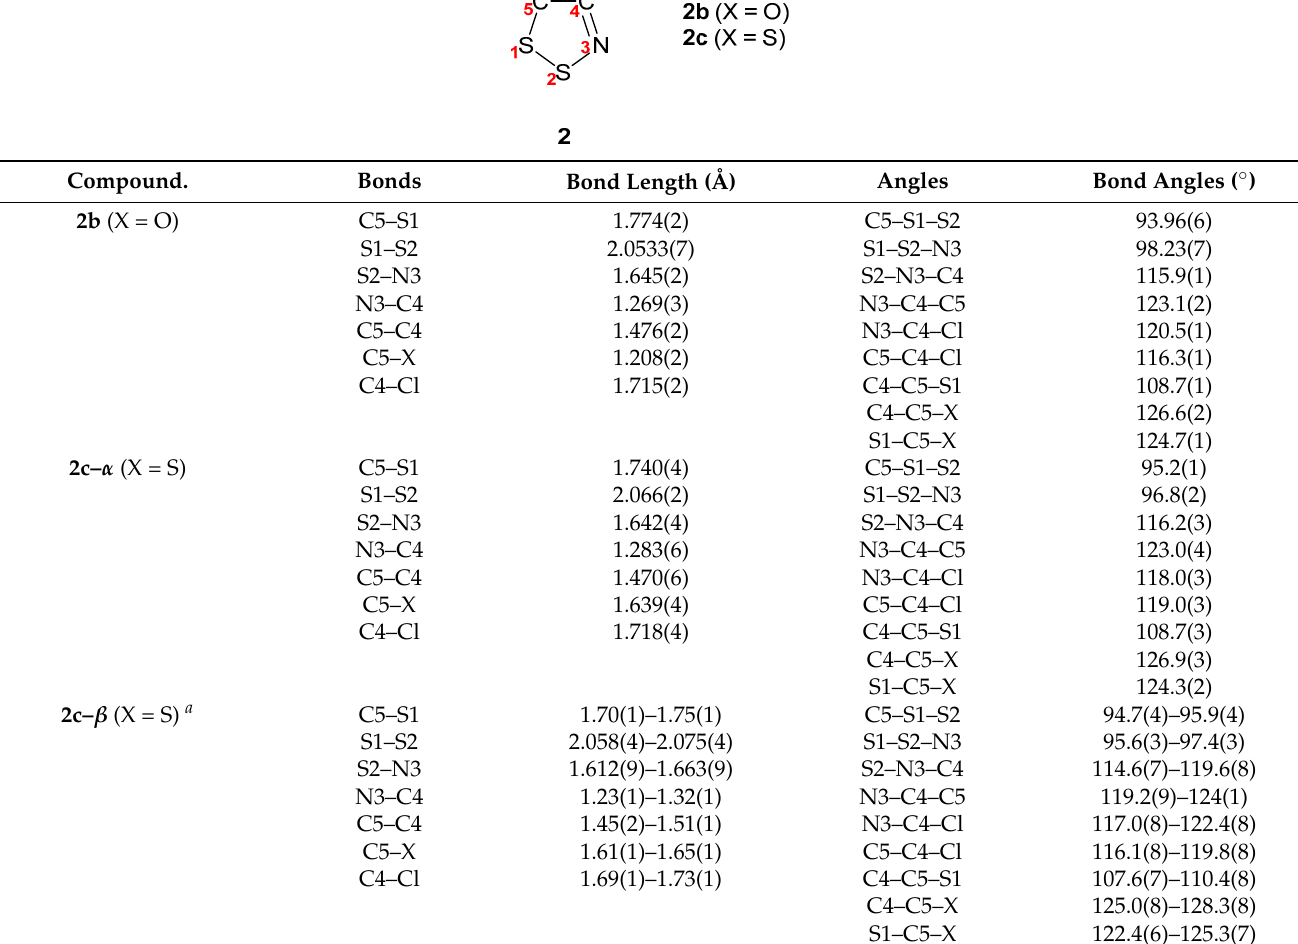
Molecules 2021 , 26 , x FOR PEER REVIEW